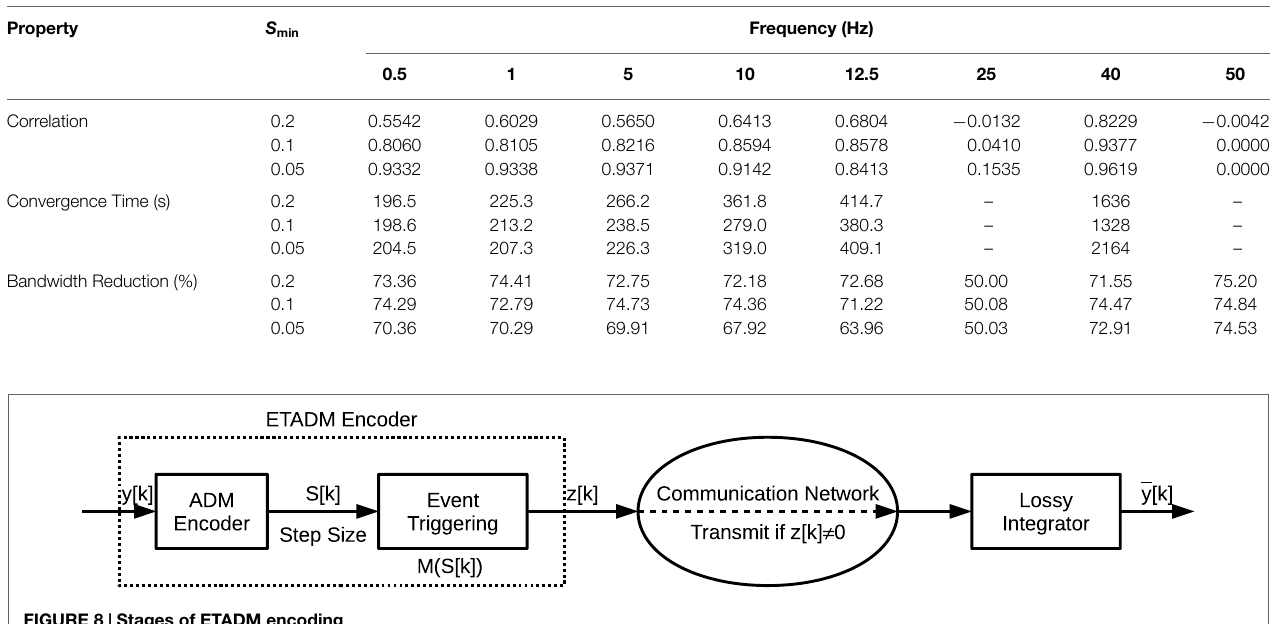
FIGURE 8 | Stages of ETADM encoding .